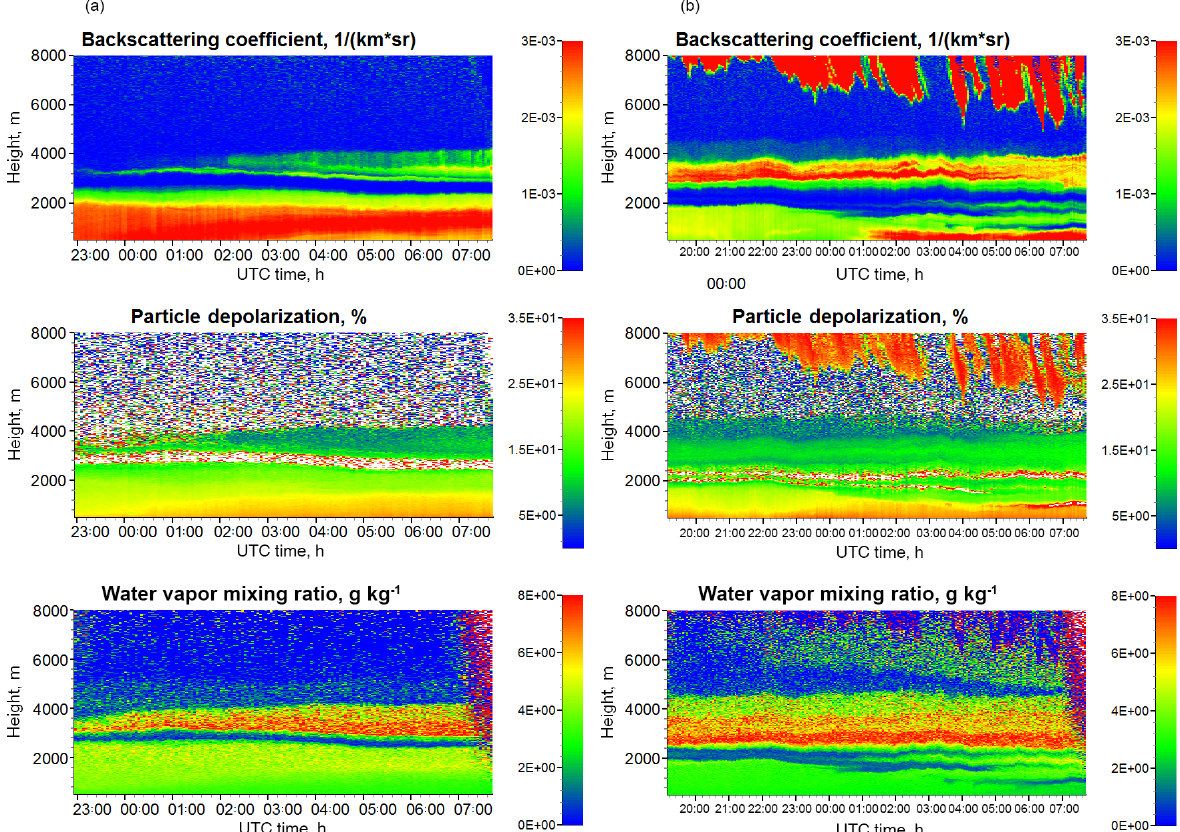
Figure 3. Height–temporal distributions of the backscattering coefficient and particle depolarization ratio at 532nm together with the water vapor mixing ratio derived from the Raman lidar measurements on the nights of 23–24 (a) and 24–25 December 2015 (b) .